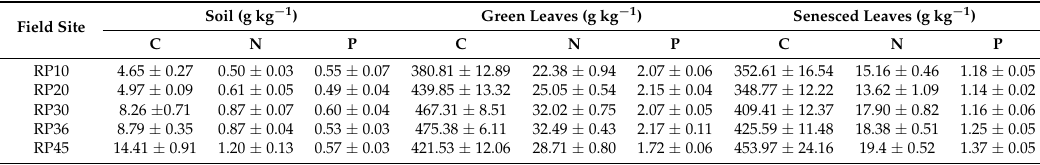
Table 2. Leaf and soil C, N, and P concentrations in different stand aged black locust